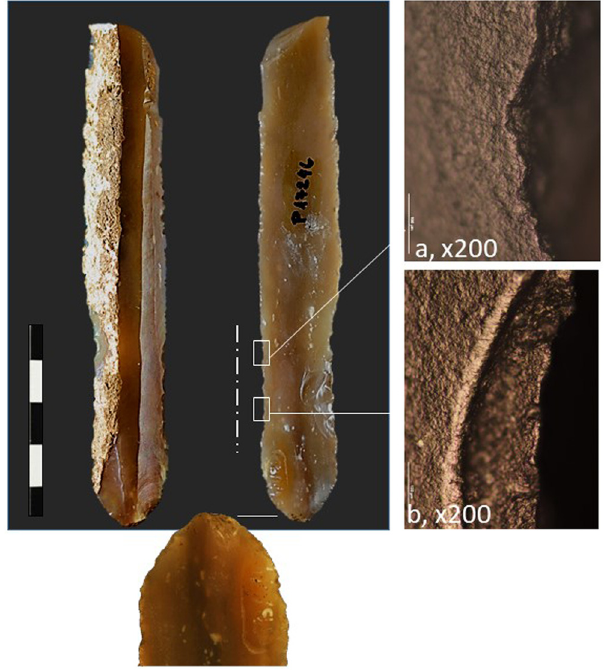
Figure 5: Cortical Blade obtained by ( lever ) pressure, used to scrape hard organic material ( a and b ) .